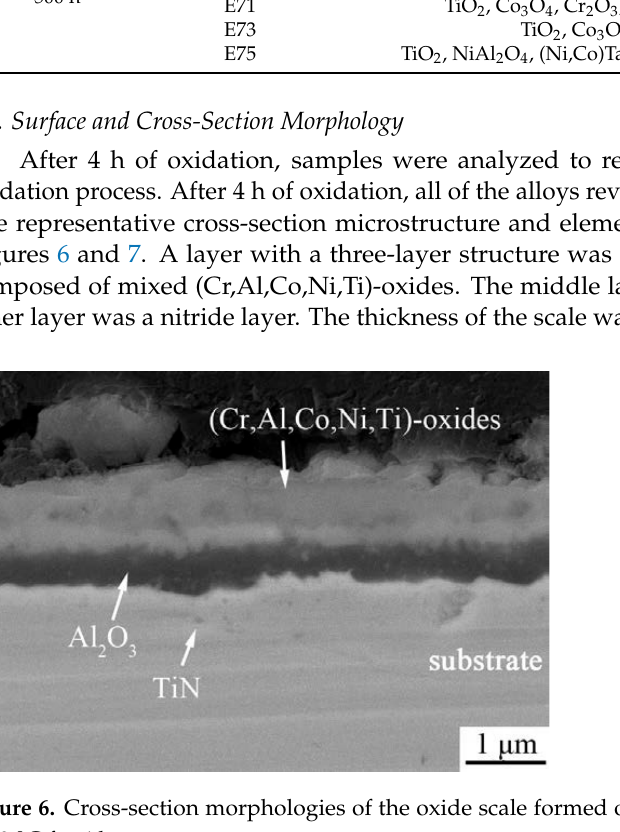
Figure 7. Secondary electron micrograph and corresponding X-ray micrograph of the E7 alloy after oxidation at 1000 °C for 4 h. The surface morphologies of the experimental alloys after isothermal oxidation at 1000 °C are illustrated in Figure 8. Two types of regions with different morphologies and constituents were formed on the samples: one is the oxides cluster made up of small gran- ular Ti-enriched oxides; the other is the plain oxides scale composed of fine oxides en- riched in Al, Ti, Cr and Ni. The four alloys differed by the relative proportion of the two regions. After 100 h of oxidation, the surface morphologies of E7 (Figure 8a) and E73 (Fig- ure 8e) were similar. The morphologies of E71 (Figure 8c) and E75 (Figure 8g) were alike. The amount of Ti-rich oxides on their surfaces was less than that of E7 and E73. The sur- face morphologies of E7, E71 and E73 alloys did not change significantly after 500 h of oxidation. For E75, however, spallation occurred, exposing the bare substrate.